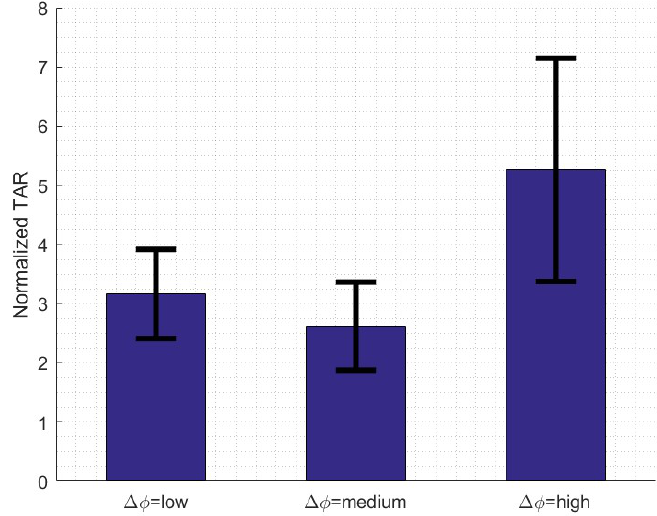
Figure 9. Normalized TAR as a function of distance between allocation resource alternatives.